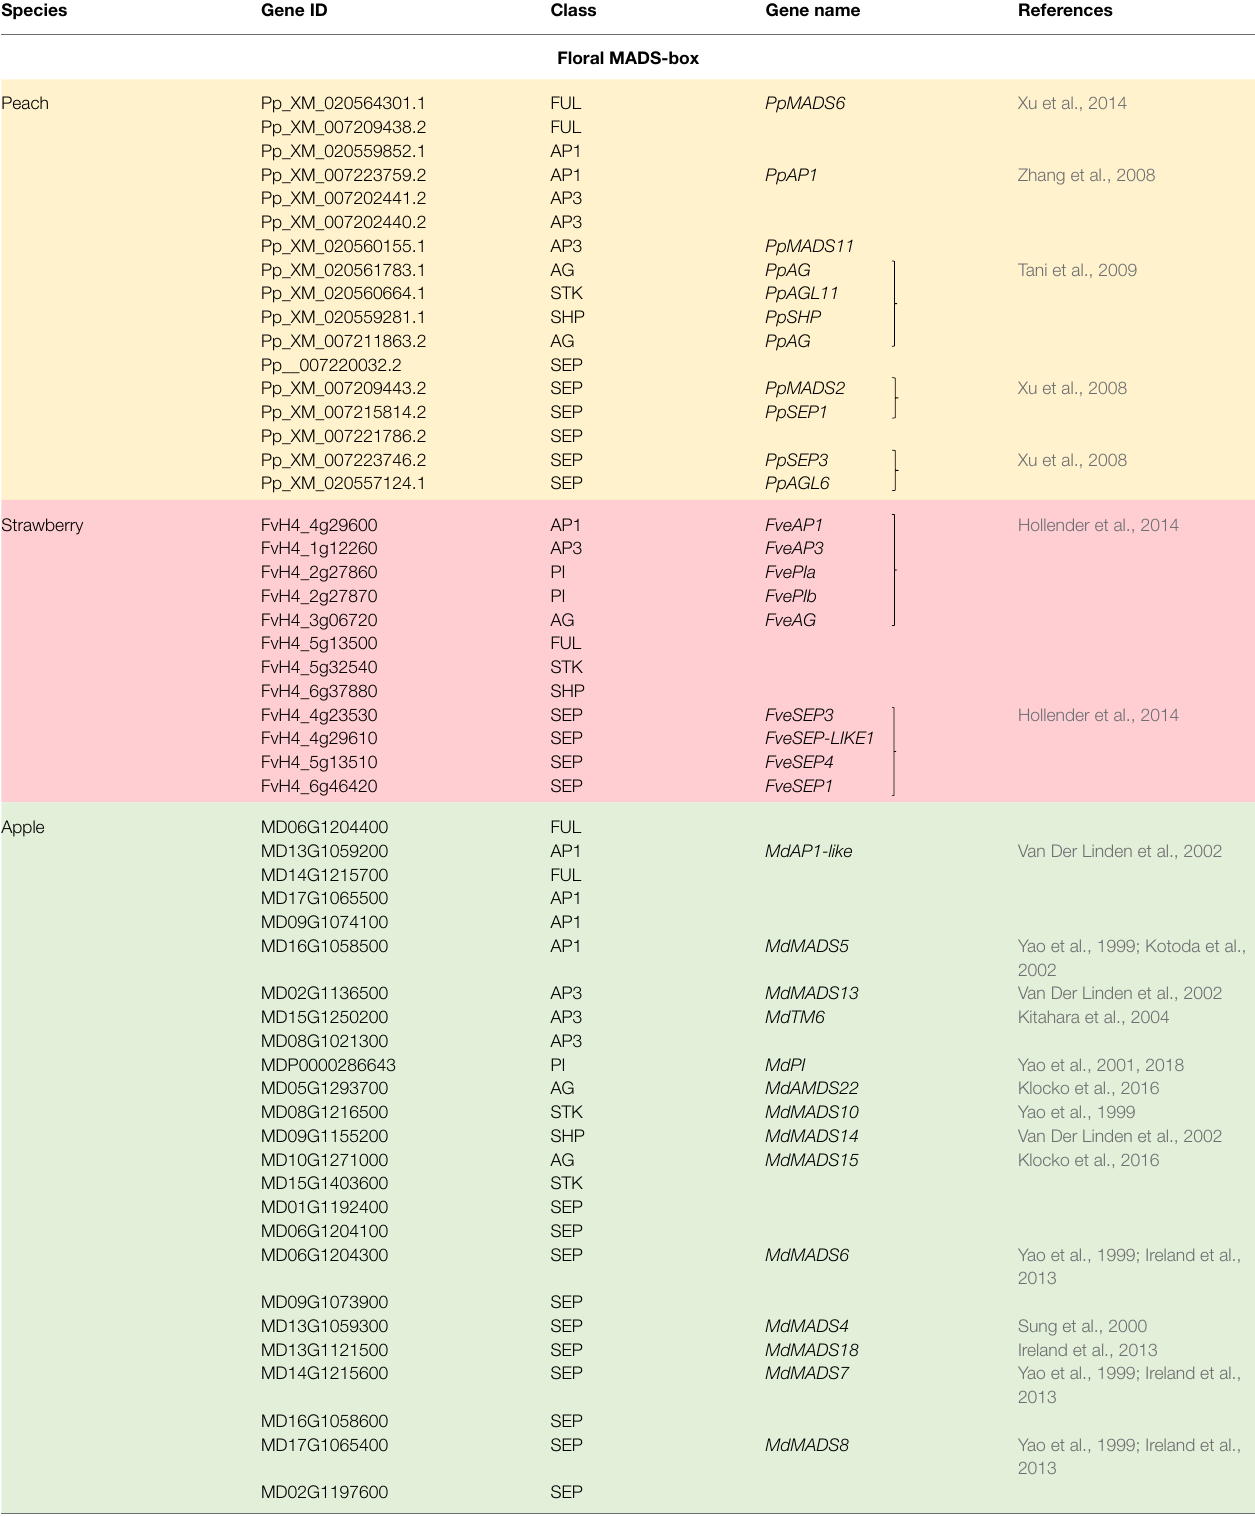
TABLE 1 | Floral MADS-box and AP2 genes in peach, strawberry, and apple.